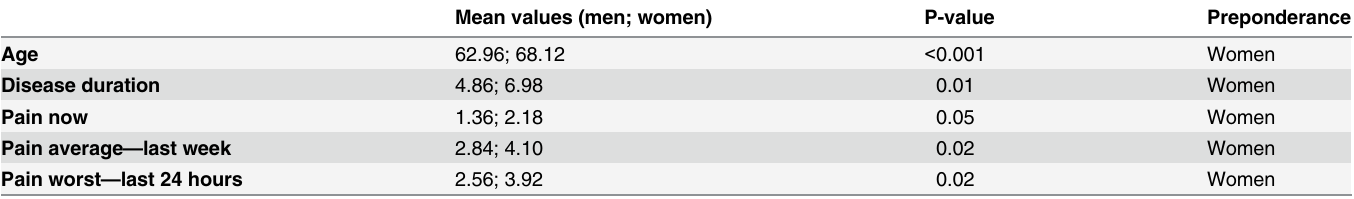
Table 5. Comparison of the pain characteristics between the sexes (variables with significant